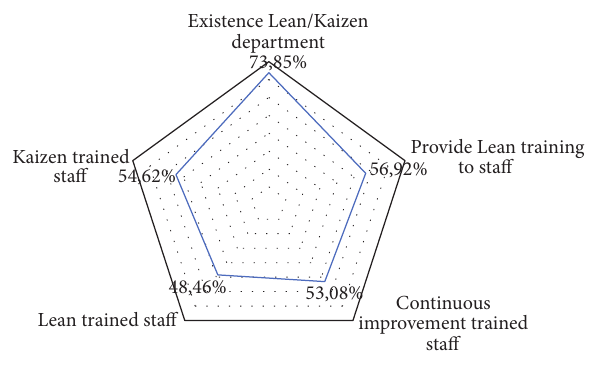
Figure 14: Most presenting types of training. Table 1: Role of the